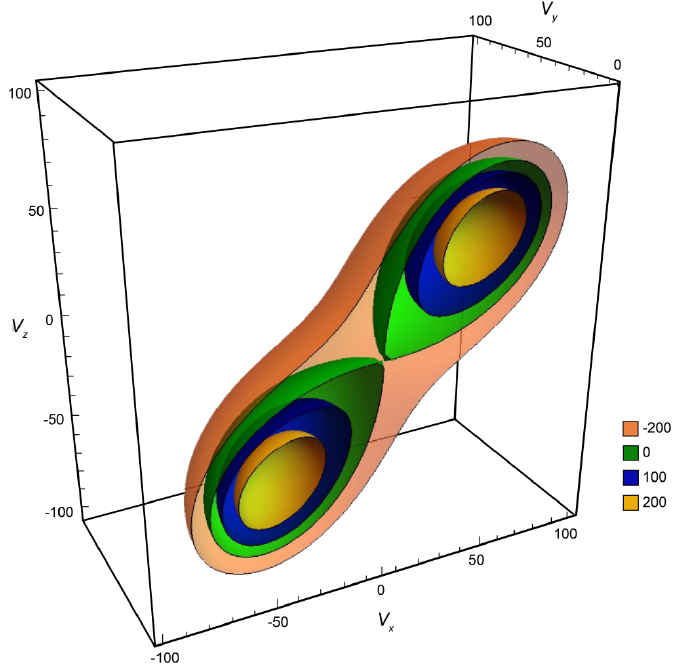
Figure 5. Sectional drawing of the contour plot of d ( E/m ) /dt .